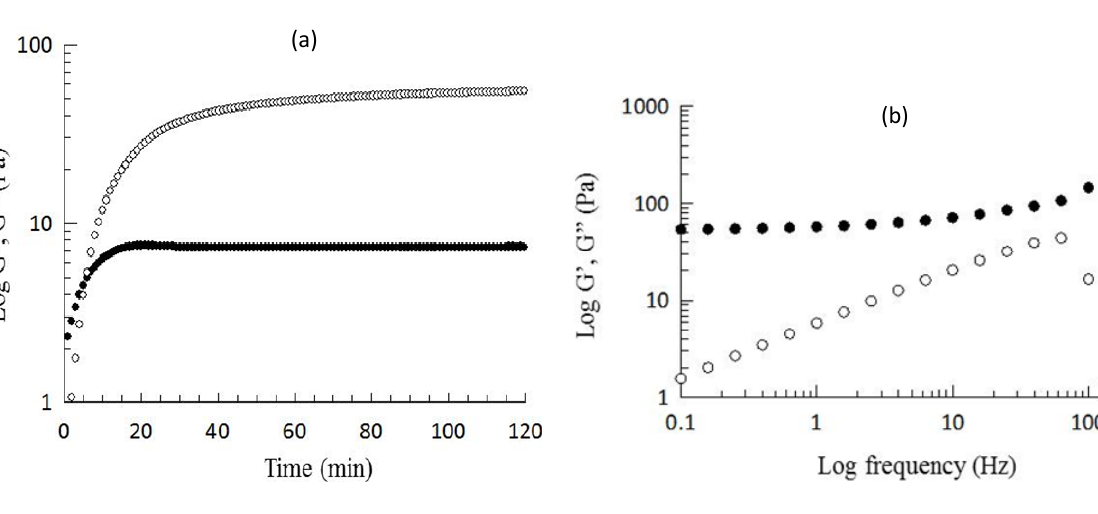
Figure 2. WEAX aerogel